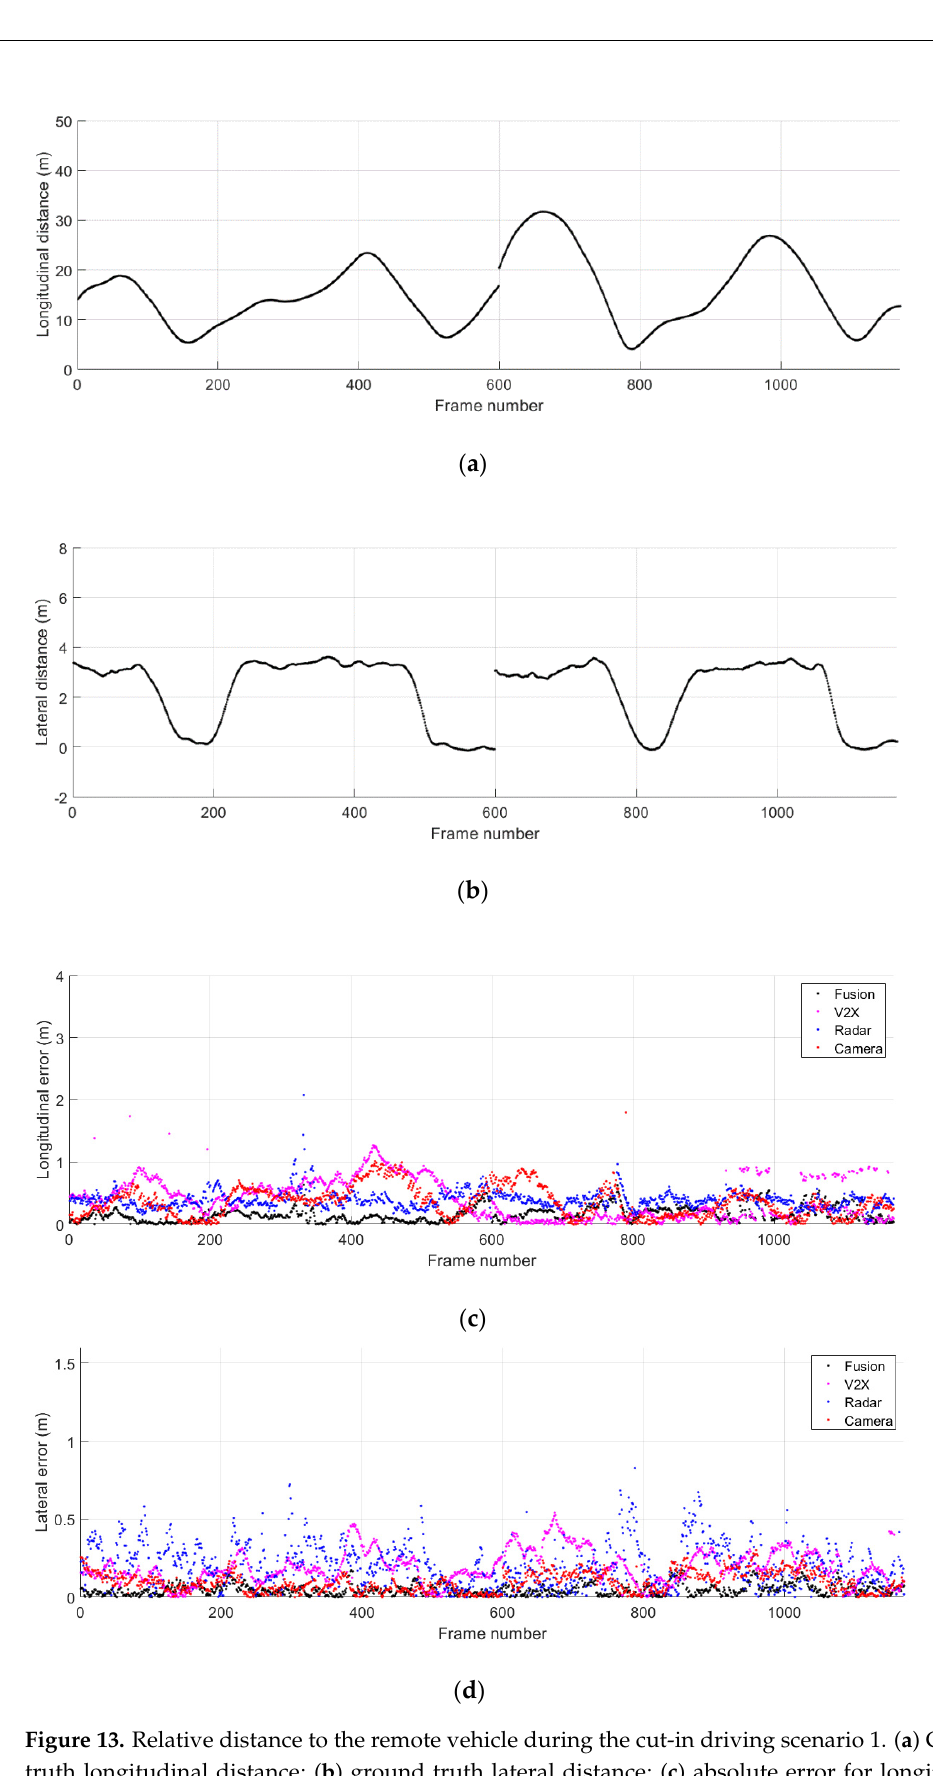
Figure 13. Relative distance to the remote vehicle during the cut-in driving scenario 1. ( a ) Ground truth longitudinal distance; ( b ) ground truth lateral distance; ( c ) absolute error for longitudinal distance estimates; ( d ) absolute error for lateral distance